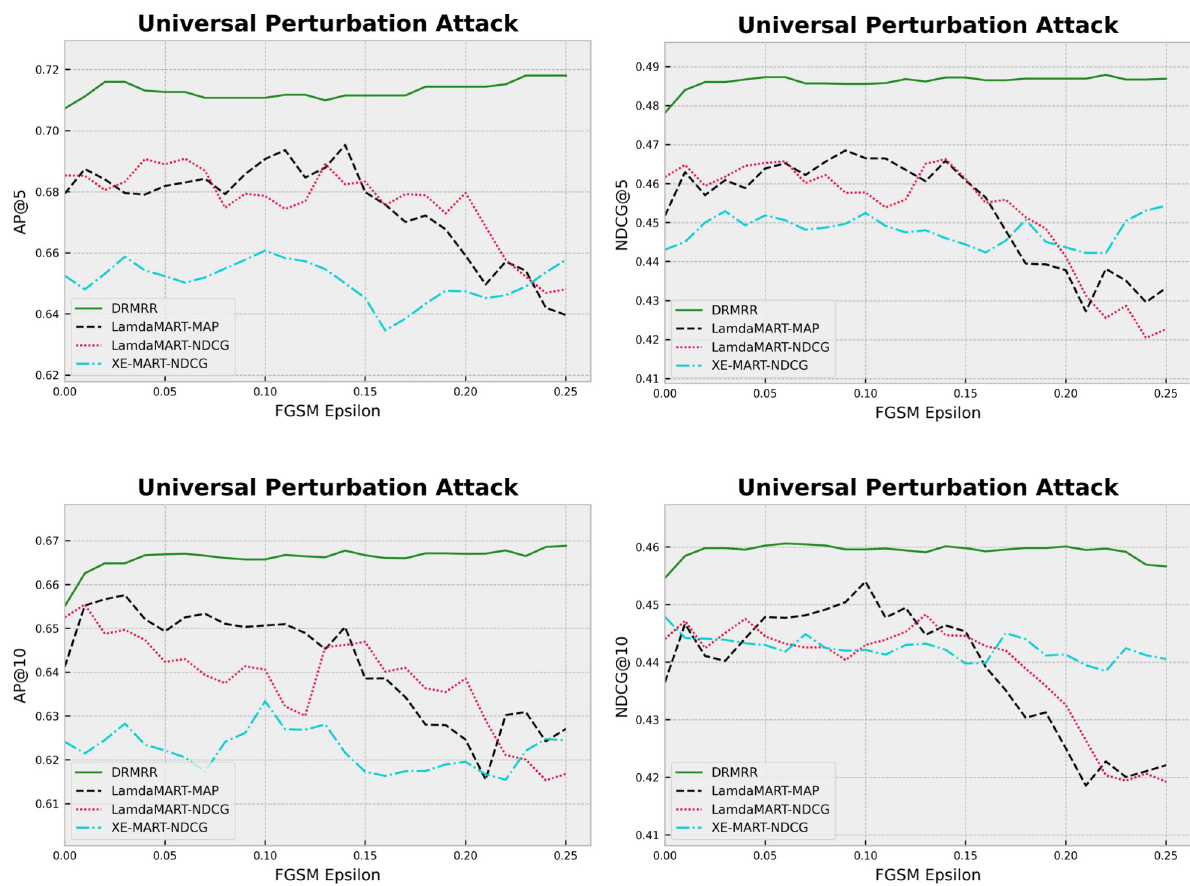
Fig 3. The impact of universal adversarial perturbation on the performance of ranking